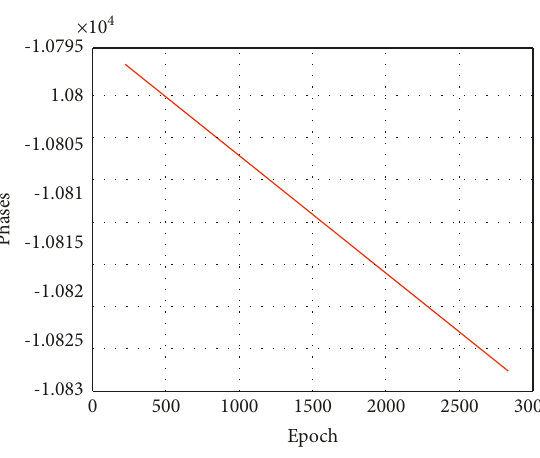
Figure 1: PRN10 satellite clock error data.